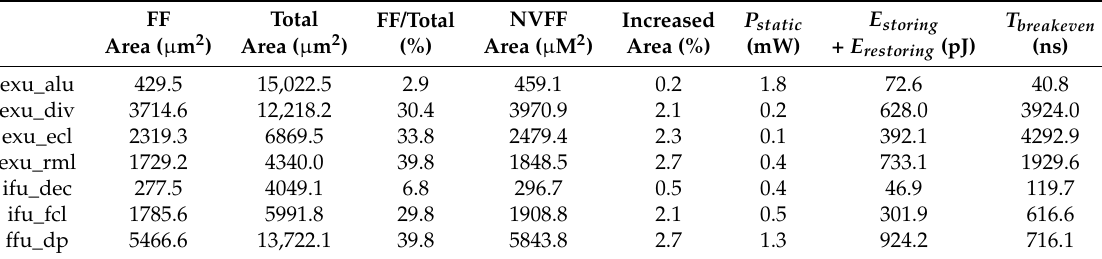
Table 3. Performance summary of seven modules.